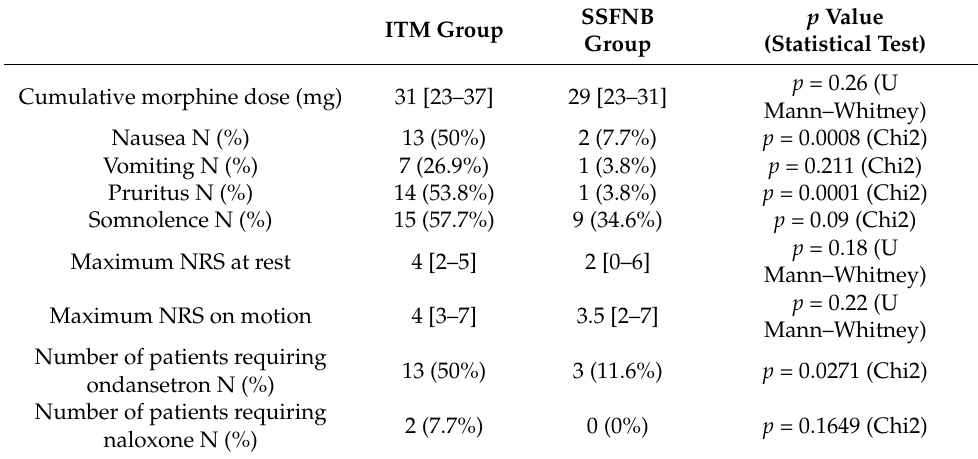
Table 2. Treatment results.